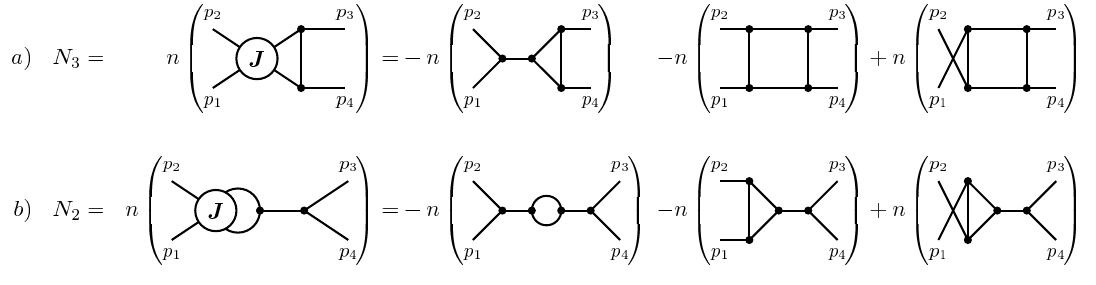
Figure 3 . Jacobi combinations for 2